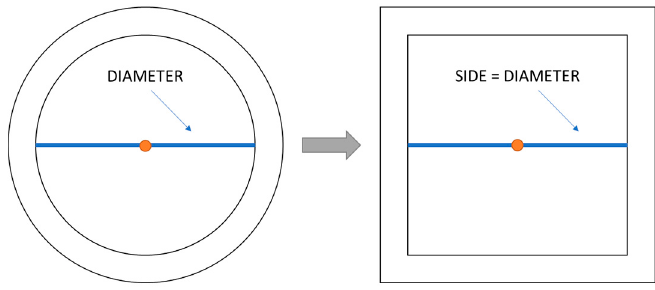
Figure 7. Approximation of the anchor rings by squares.